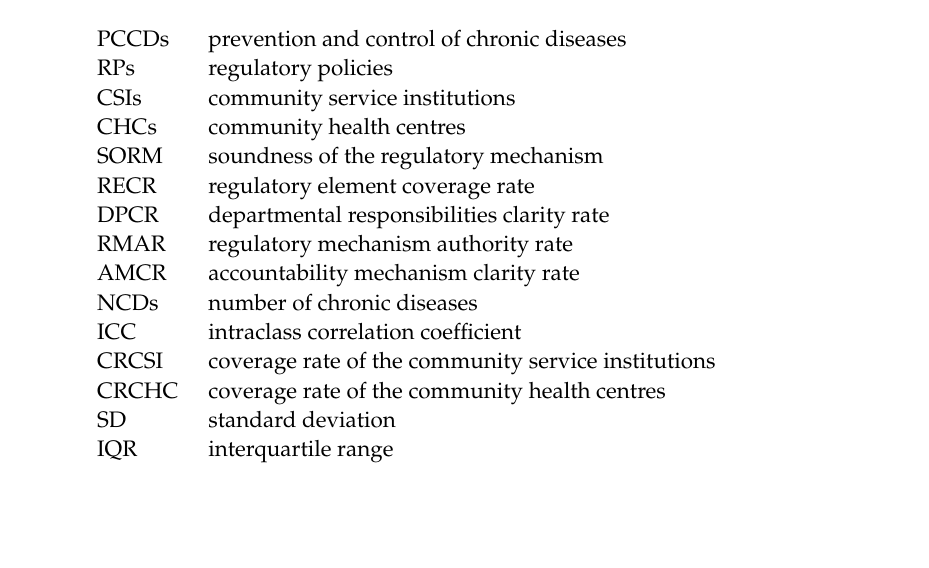
Table A1. Coding